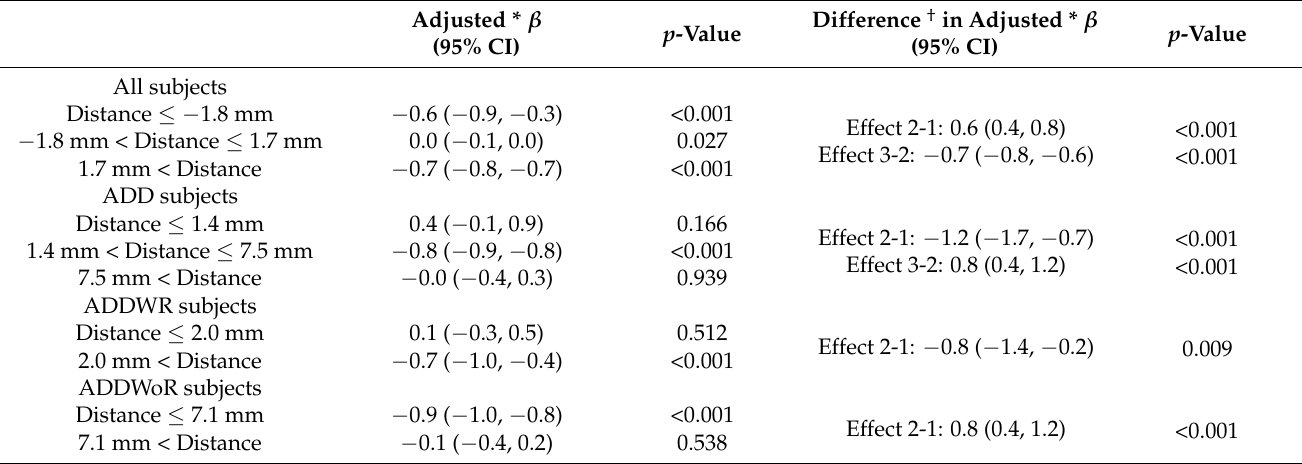
Table 6. Threshold effect analysis of disc displacement distance on disc length using two piece-wise linear